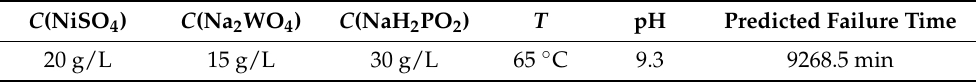
Table 4. Optimal technological parameters for electroless Ni–W–P